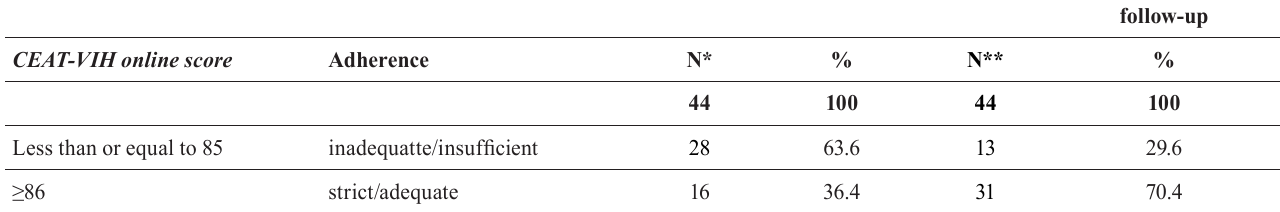
After Before pharmacotherapeutic follow-up